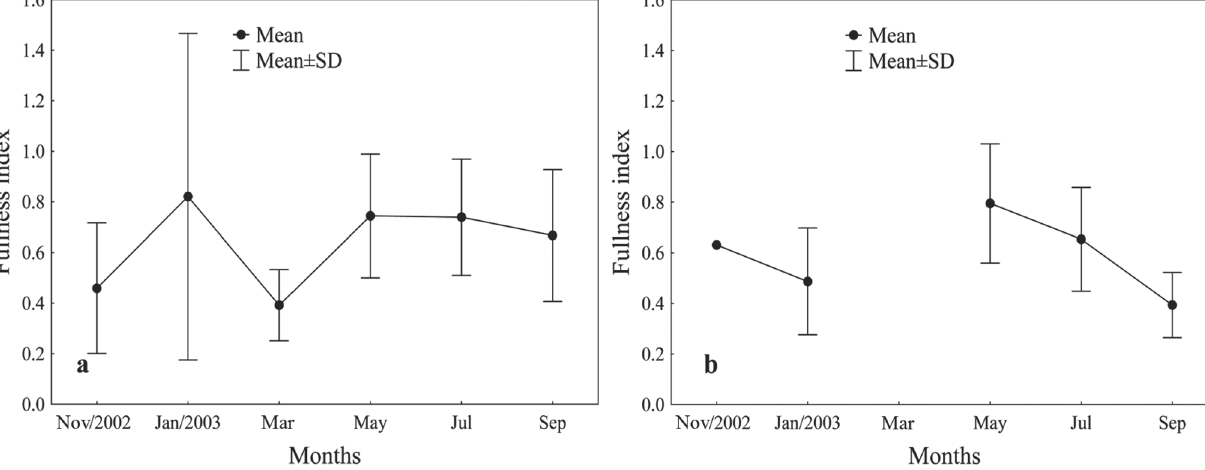
Fig. 6 . Bimonthly variation of the mean values of the fullness index (FI) of females (a) and males (b) of Iheringichthys labrosus in the Piquiri River from November 2002 to September 2003. (SD = Standard